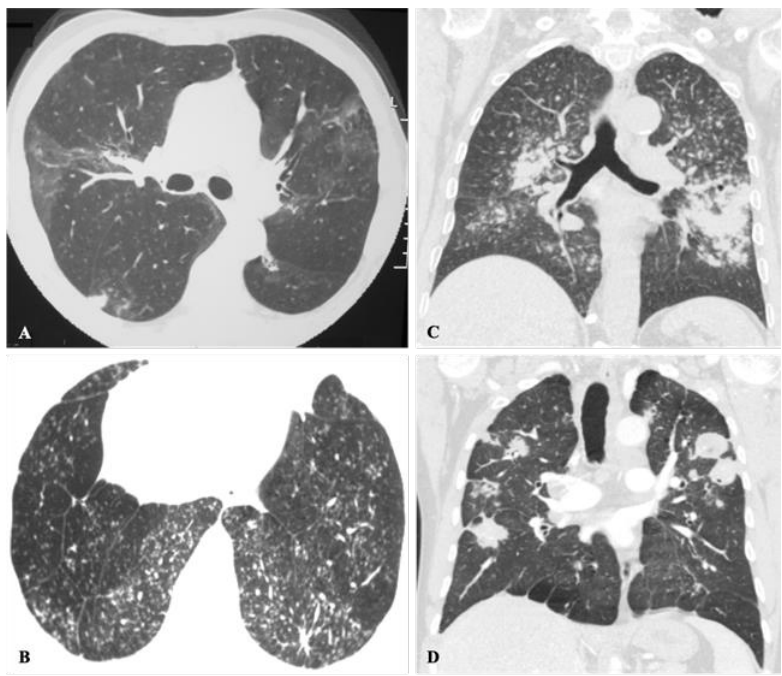
Figure 12. Imaging findings in different patients with paracoccidioidomycosis. The changes are often bilateral, affecting both central and peripheral lung areas and may predominate in the middle zones. The changes are often combined; however, some patterns may prevail. Imaging findings may include patchy bilateral predominant ground-glass opacities ( A ), multiple bilateral small nodules ( B ), bilateral consolidations with associated nodules ( C ), and a dominant pattern of large bilateral nodules ( D ).